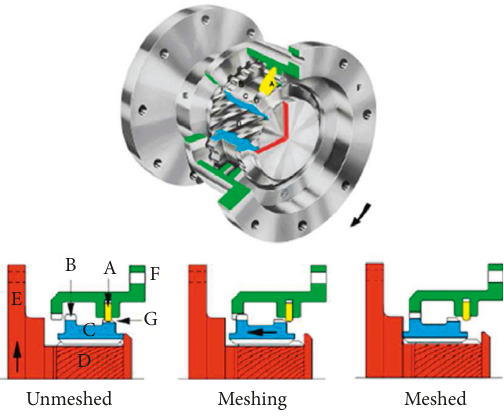
Figure 1: Meshing process of an SSS